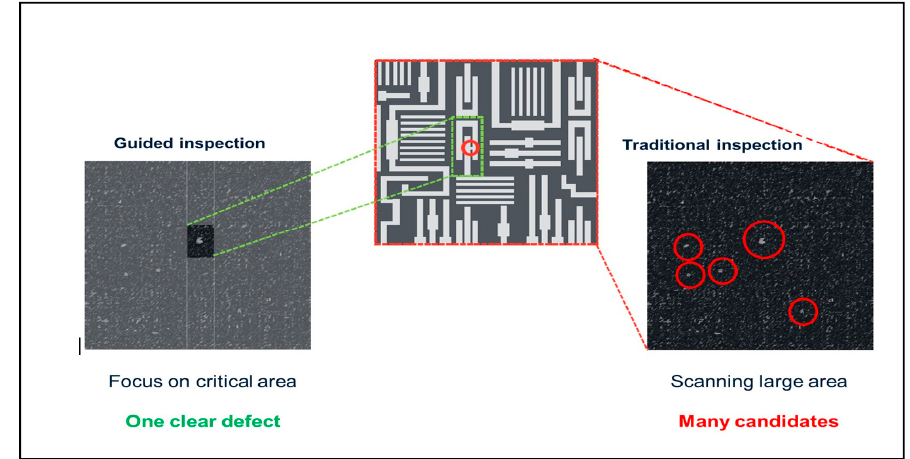
Figure 6. Comparison between guided and traditional inspections. A guided inspection produces a clear defect, while the traditional inspection results in many defect candidates.